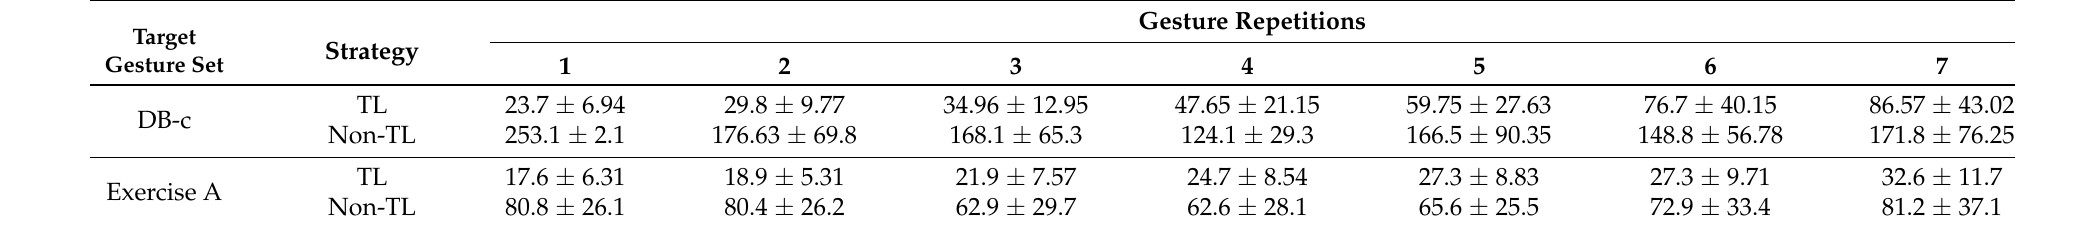
Table 3. The comparison of training time(s) between the TL strategy and non-TL strategy for new subject